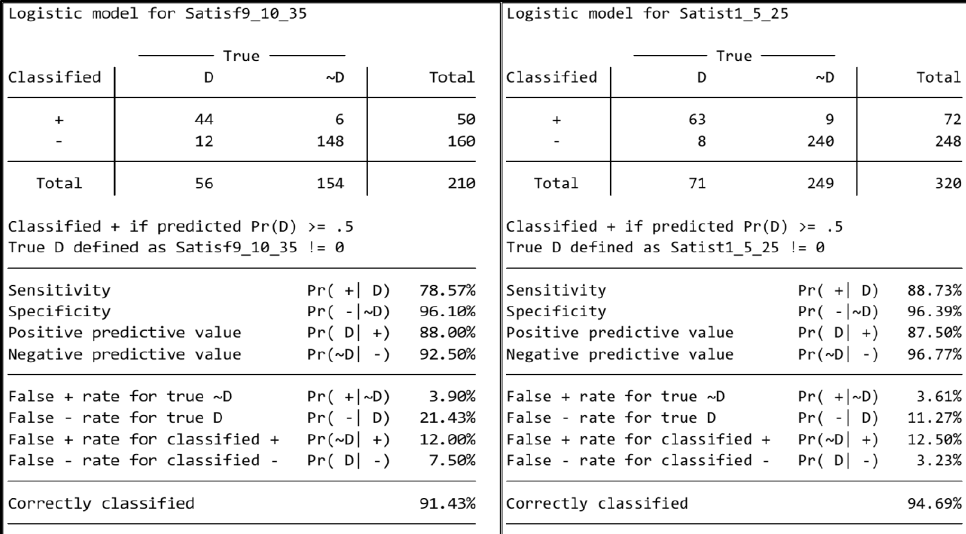
Figure 1. Classification statistics and table logit models (Models 1 y 2).